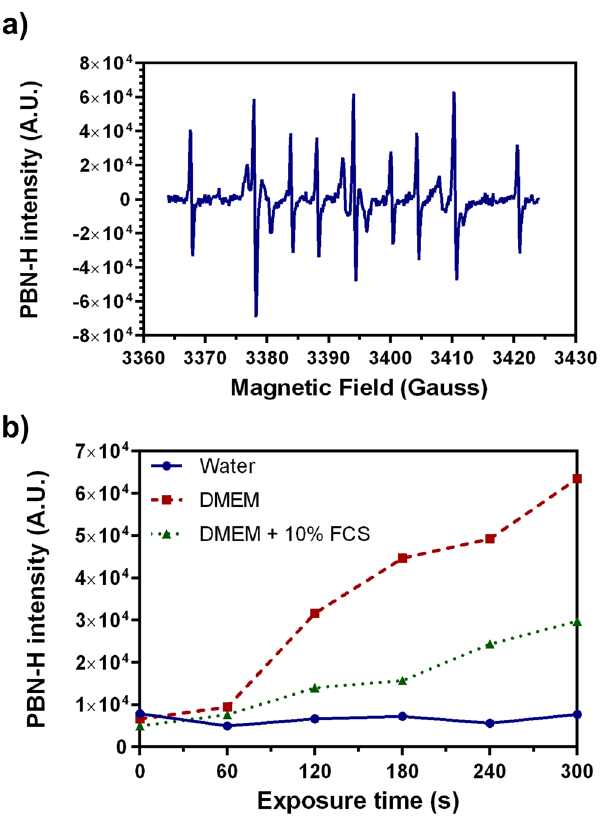
Figure 6. ( a ) PBN-H spectrum obtained after 150 s of plasma treatment in DMEM. ( b ) Effect of plasma exposure on PBN-H signal in three solvents. Half height of the middle peak was chosen to represent PBN-H